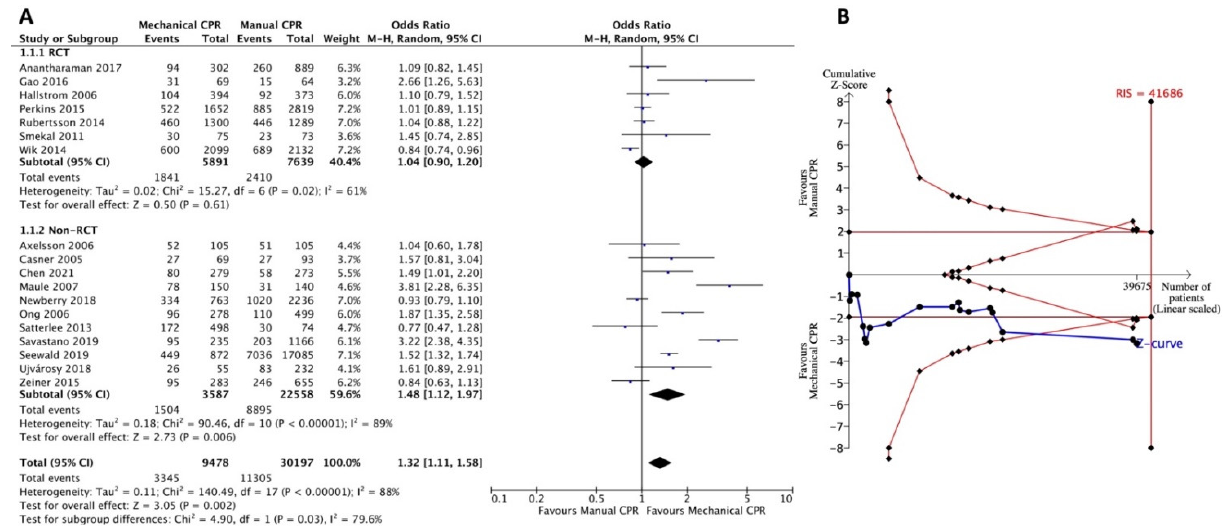
Figure 2. Forest plot ( A ) and trial sequential analysis ( B ) for return of spontaneous circulation between mechanical CPR device and manual CPR. CPR: cardiopulmonary resuscitation; CI: confidence interval; RCT: randomized controlled trial; RIS: required information size.